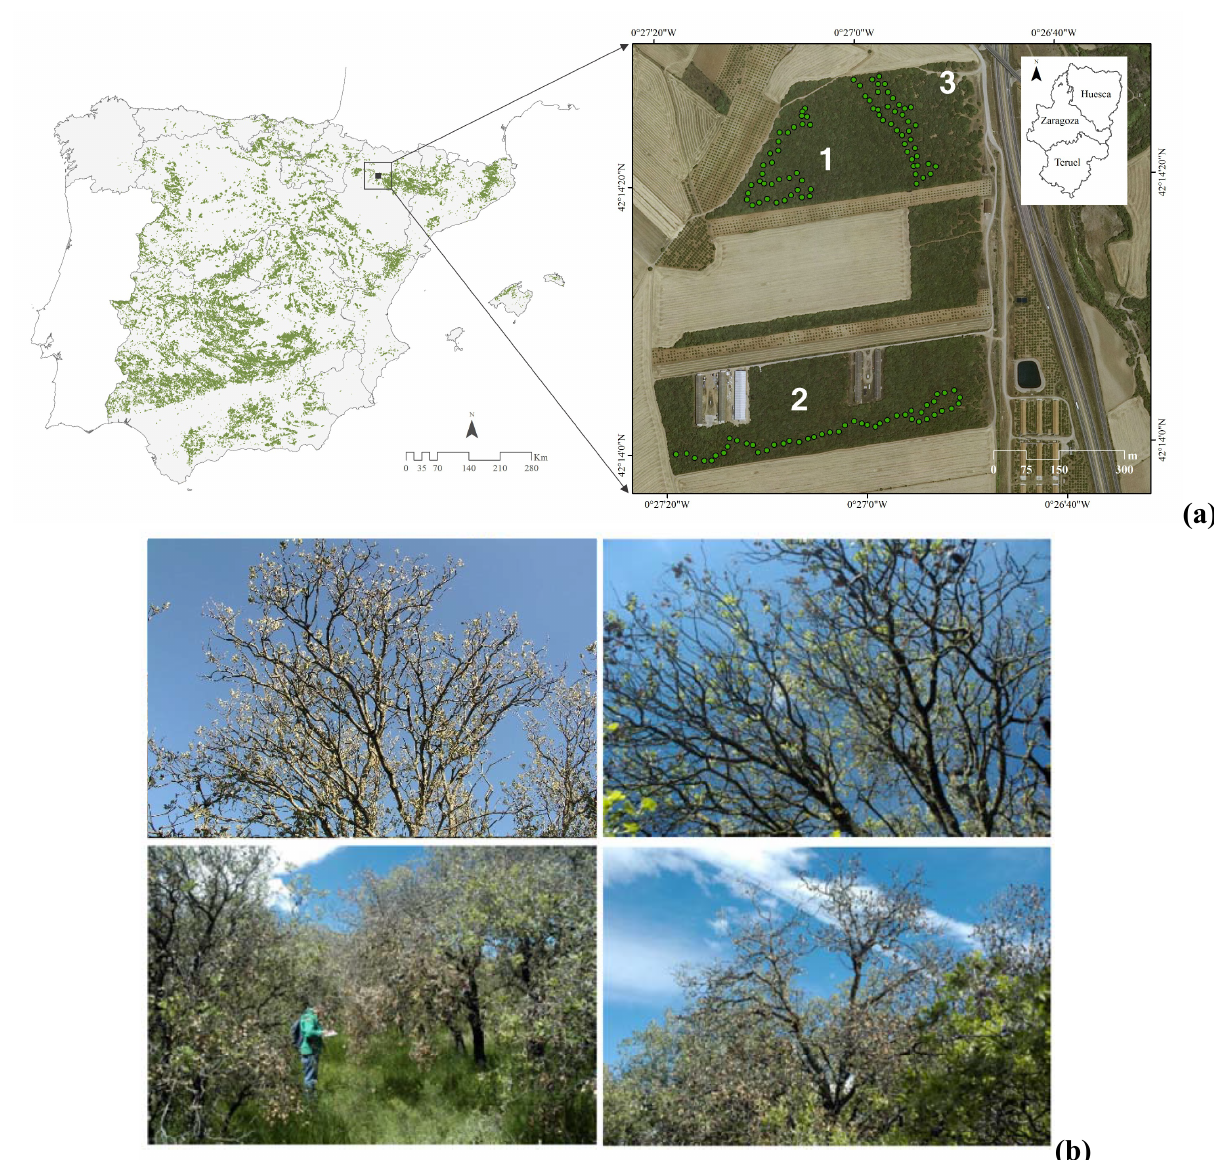
Figure 1. ( a ) Distribution of holm oak in Spain (green patches) and location of the studied holm oak forests (sites 1, 2 and 3) and trees (dots) with ( b ) views of defoliated trees after the severe 2005 (uppermost left photograph) and 2012 (rest of images) droughts. The nearby sites 1 and 3 were considered the same sampling unit regarding primary growth and remote sensing